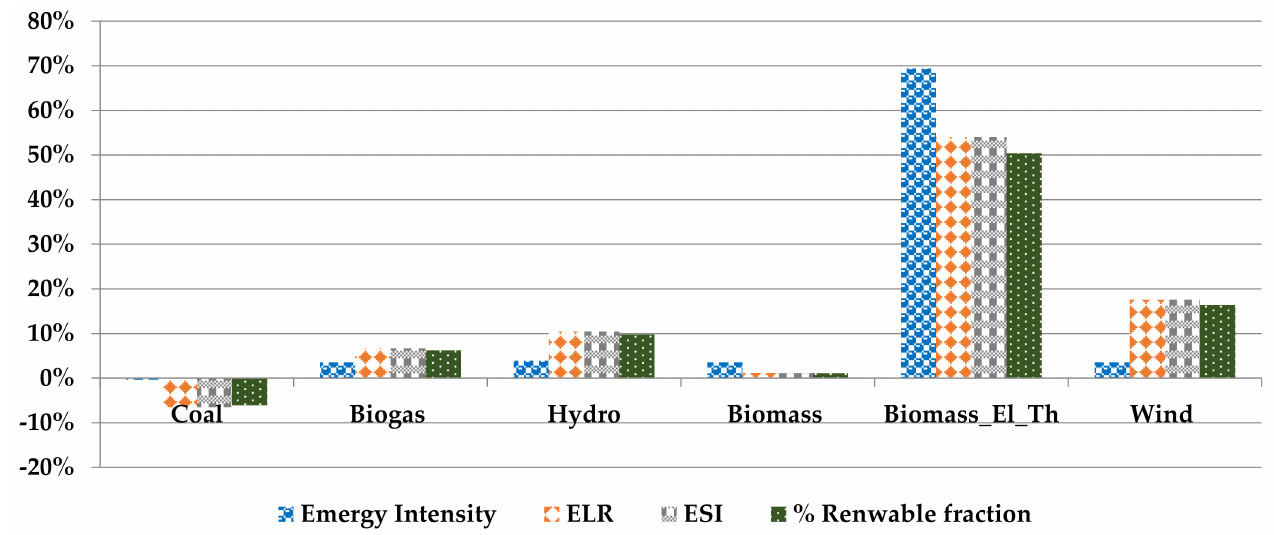
Figure 7. Comparative analysis of emergy flows and emergy-based indicators for the biodiesel production